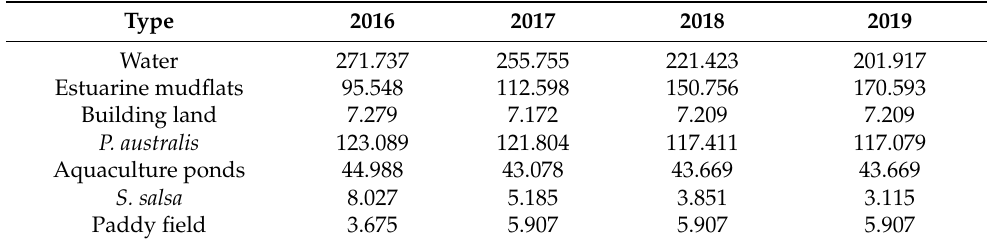
Figure 3. Changes in landscape patterns in the study area from 2016 to 2019. Table 5. Area of each type (km 2